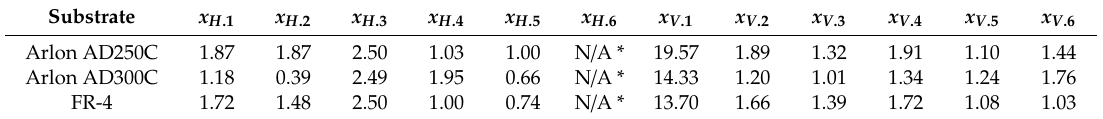
Table 4. Dimensions of the B A (2,4) coupler re-designed for di ff erent substrates.